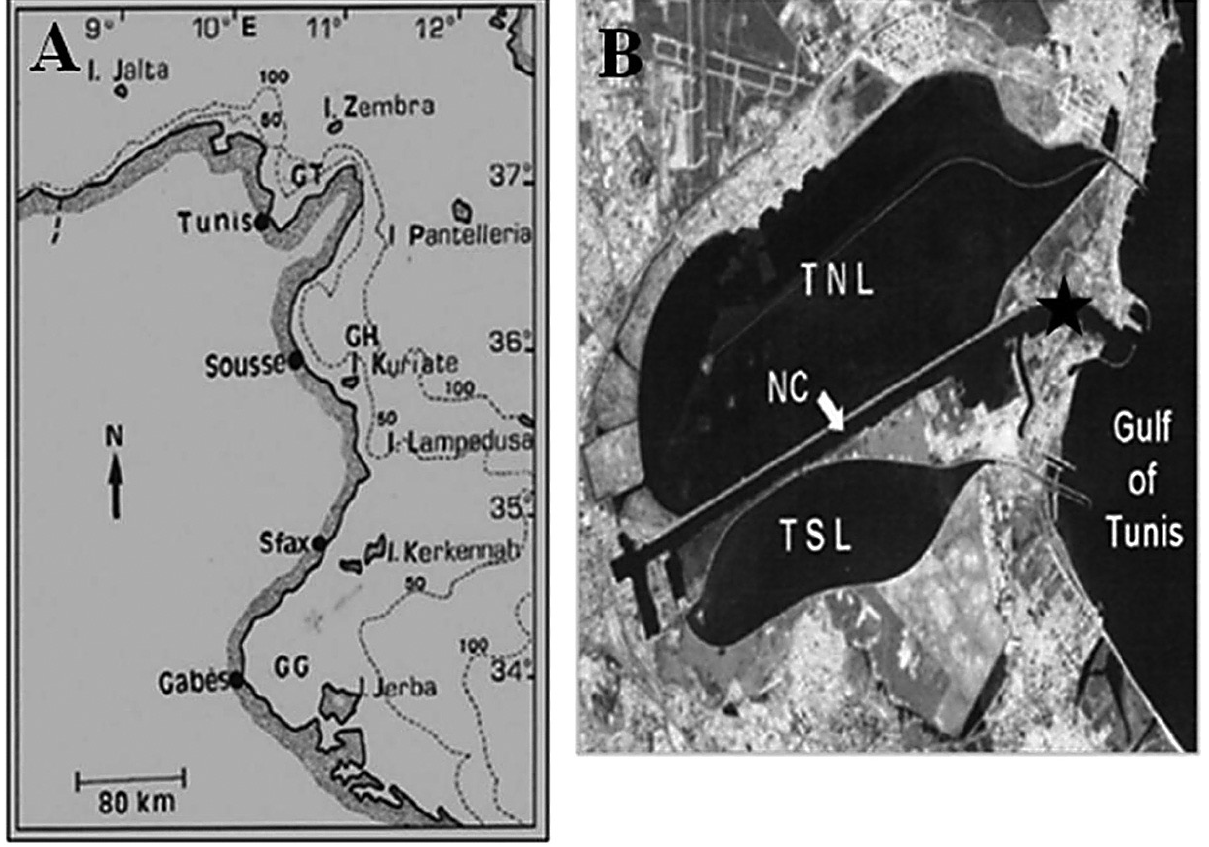
Fig. 1. – A, map of Tunisia with the Gulf of Tunis (GT), the Gulf of Hammamet (GH) and the Gulf of Gabes (GG). B, map of Tunis Lagoon divided by channel navigation (NC) in two areas Tunis Northern lagoon (TNL) and Tunis Southern Lagoon (TSL) and location of the sam- pling site inside the navigation